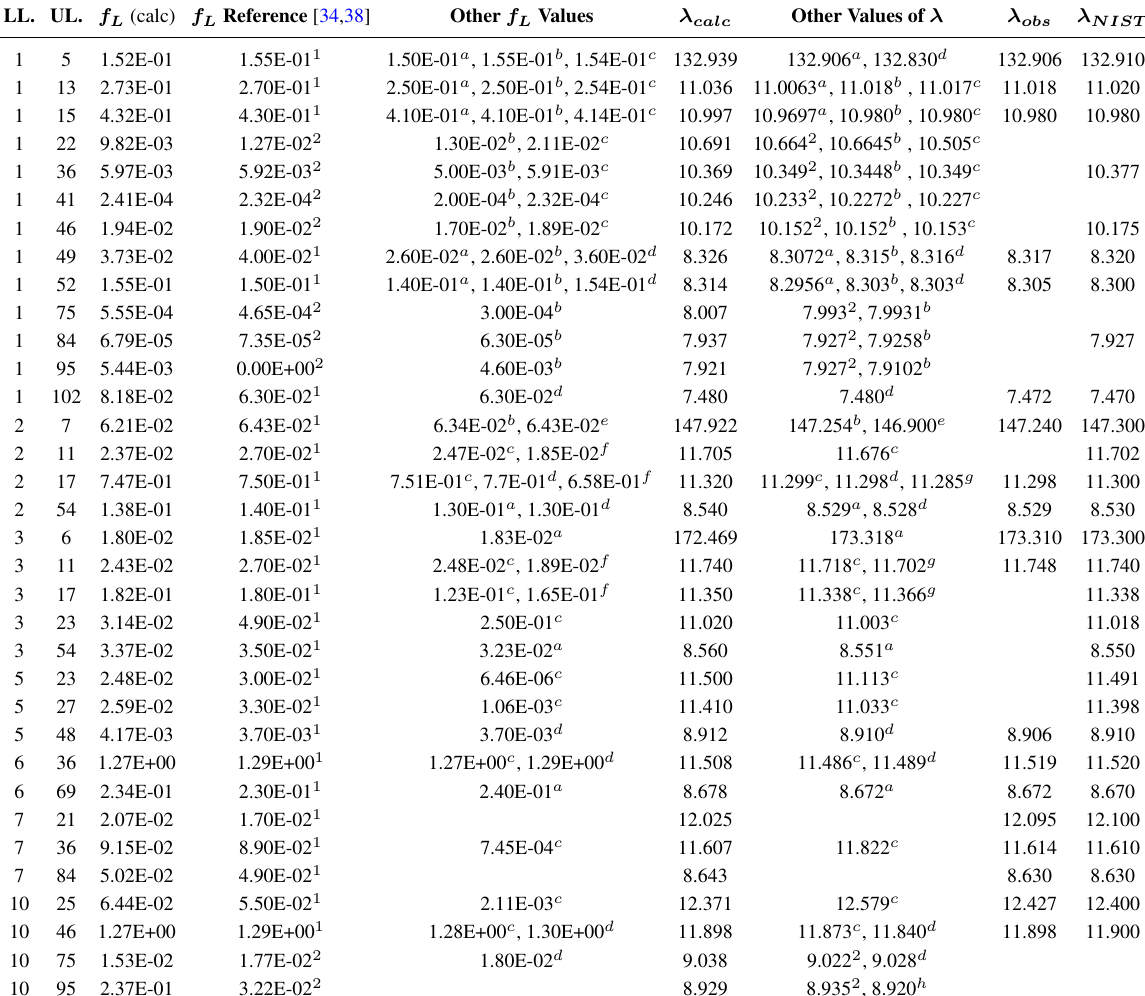
Table 4. Comparison between the present calculations of oscillator strengths f and wavelengths ( λ in Å) and other published data for some transitions in Be-like iron. calc LL. = lower level; UL. = upper level, λ denotes the Ritz wavelength from the NIST NIST database